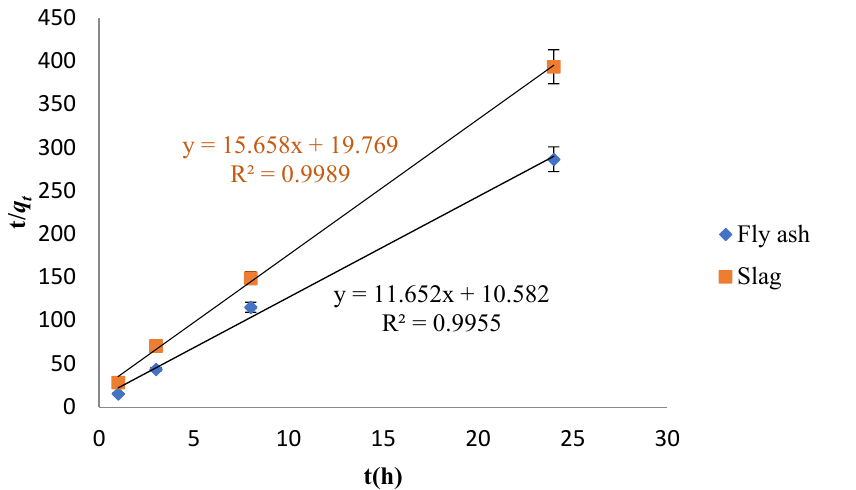
Figure 7. Pseudo-second-order linear kinetic model of Cs adsorption on the fly ash-based geomaterials and slag-based geomaterials. Table 3. Parameters for two kinetic models of Cs adsorption by fly ash-based geomaterials and slag-based geomaterials. Sample